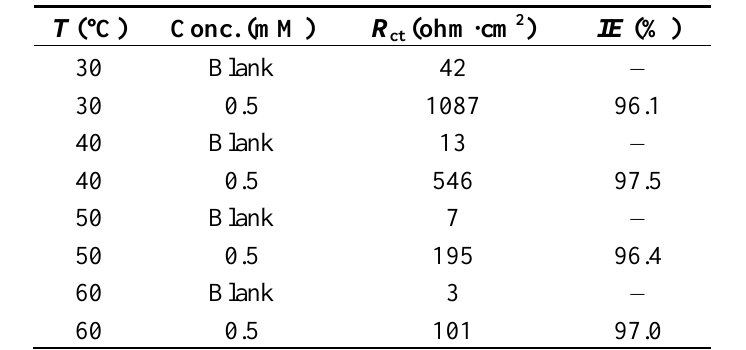
Table 4. Inhibition efficiency of PMBH calculated from EIS results as a function of temperatures.